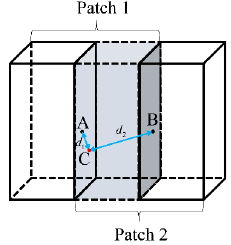
Figure 7. A schematic diagram of the overlapping patches. The shaded regions represent overlap. Points A and B are the center points of patch 1 and patch 2, respectively, and point C is a point in the overlap region. The predicted value of point C in patch 1 and patch 2 are φ A and φ B , respectively. d 1 is the distance from point C to point A when point C is in patch 1, d 2 is the distance from point C to point B when point C is in patch 2. The final predicted value is φ C . According to Equation (6), the weights of point C in patch 1 and patch 2 are as follows: ω A = e − d 1 we can get φ C = ω A φ A + ω B φ B from Equation